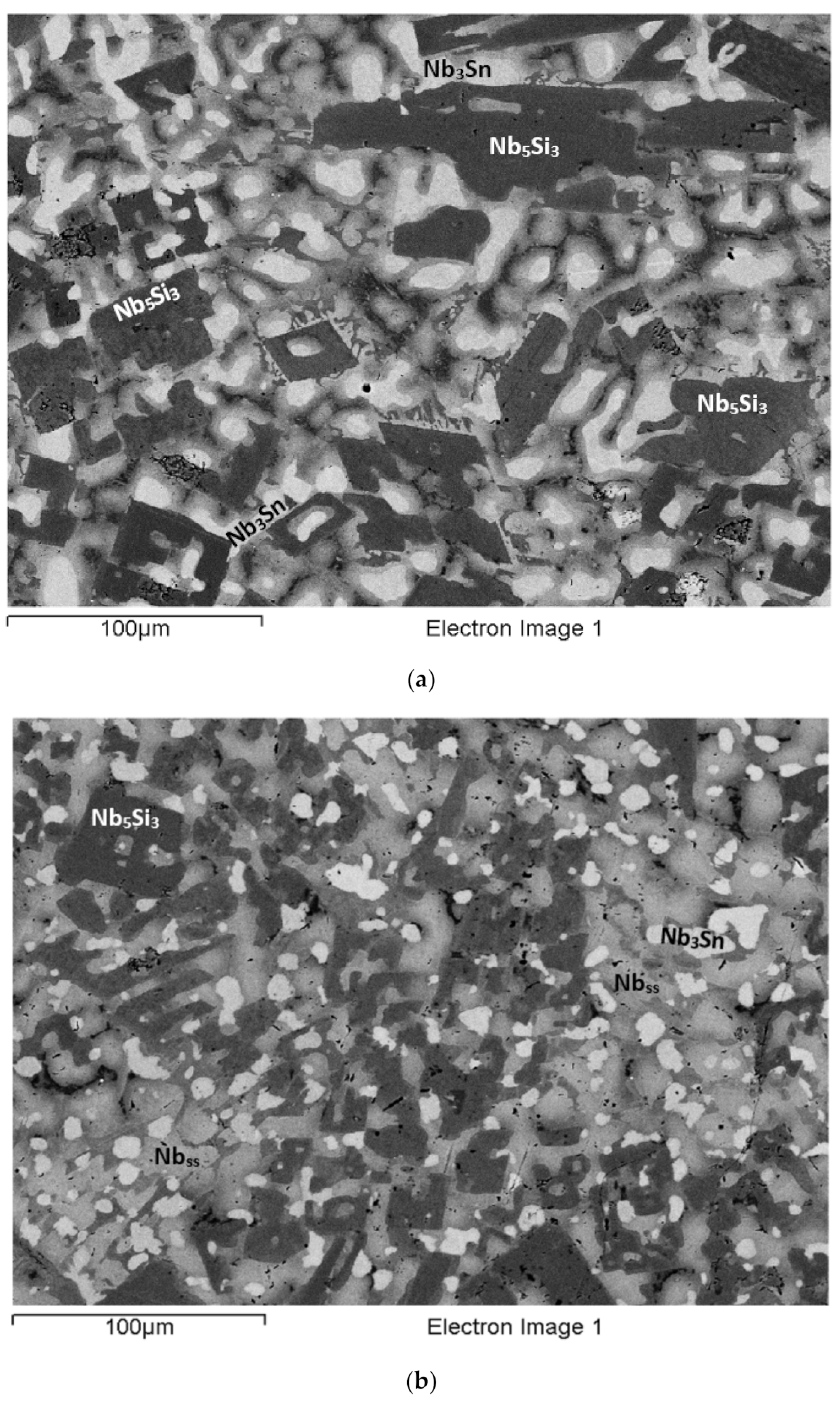
Figure 5. BSE images of the microstructure of EZ6-AC: ( a ) bulk and ( b ) bottom of ingot. Contrast has been enhanced to show all phases. The A15-Nb 3 X compound is shown as Nb 3 Sn. See Figure 6 for further details of the